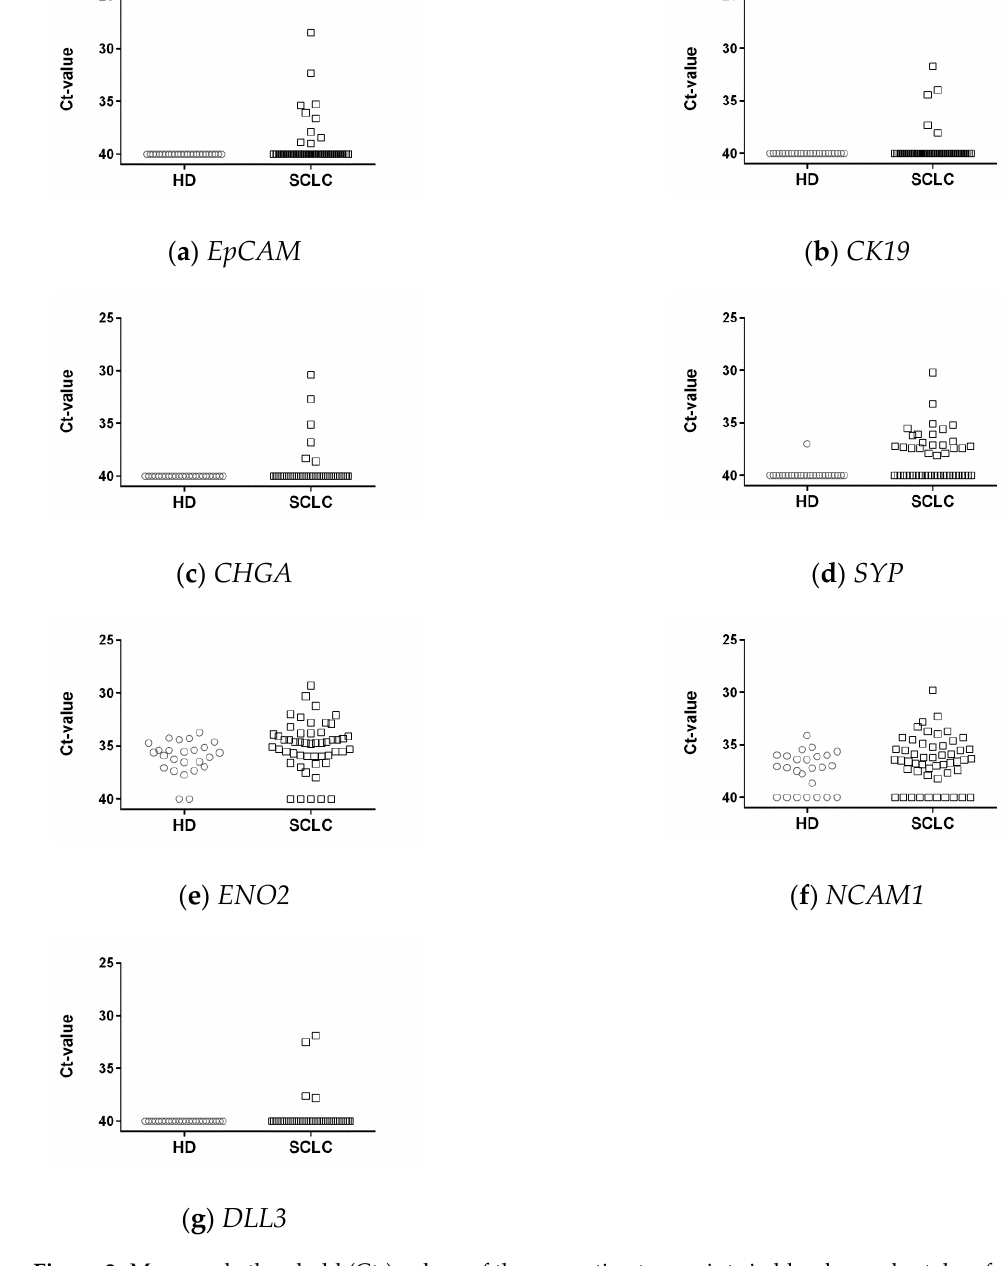
Figure 2. Mean cycle threshold (Ct-) values of the respective transcripts in blood samples taken from 26 healthy donors (HD) and 48 patients with small-cell lung cancer (SCLC). ( a ) EpCAM , epithelial cell adhesion molecule; ( b ) CK19 , cytokeratin 19; ( c ) CHGA , chromogranin A; ( d ) SYP , synaptophysin; ( e ) ENO2 , enolase 2; ( f ) NCAM1 , neural cell adhesion molecule 1; ( g ) DLL3 , Notch pathway delta-like 3 ligand.